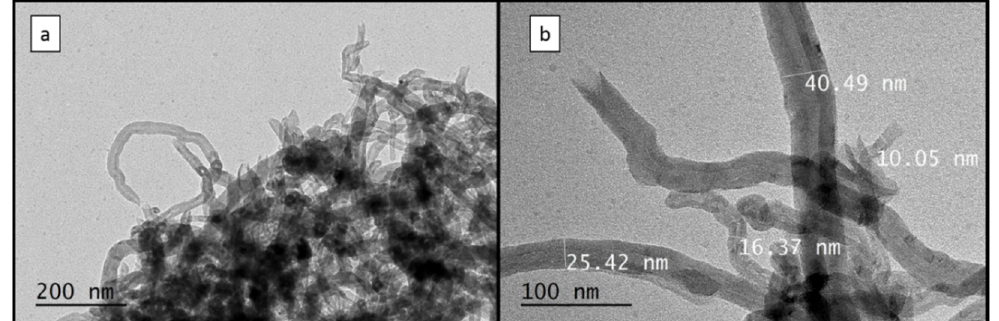
Figure 5. ( a ) Bundle of MWCNTs. ( b ) Individual nanotubes showing the multiple walls and the outer diameter measurements.